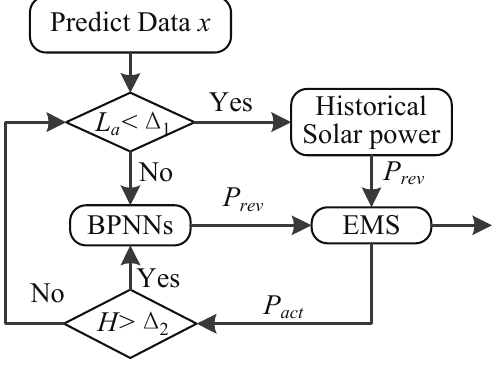
Figure 7. The flow chart for ASPF in power systems.